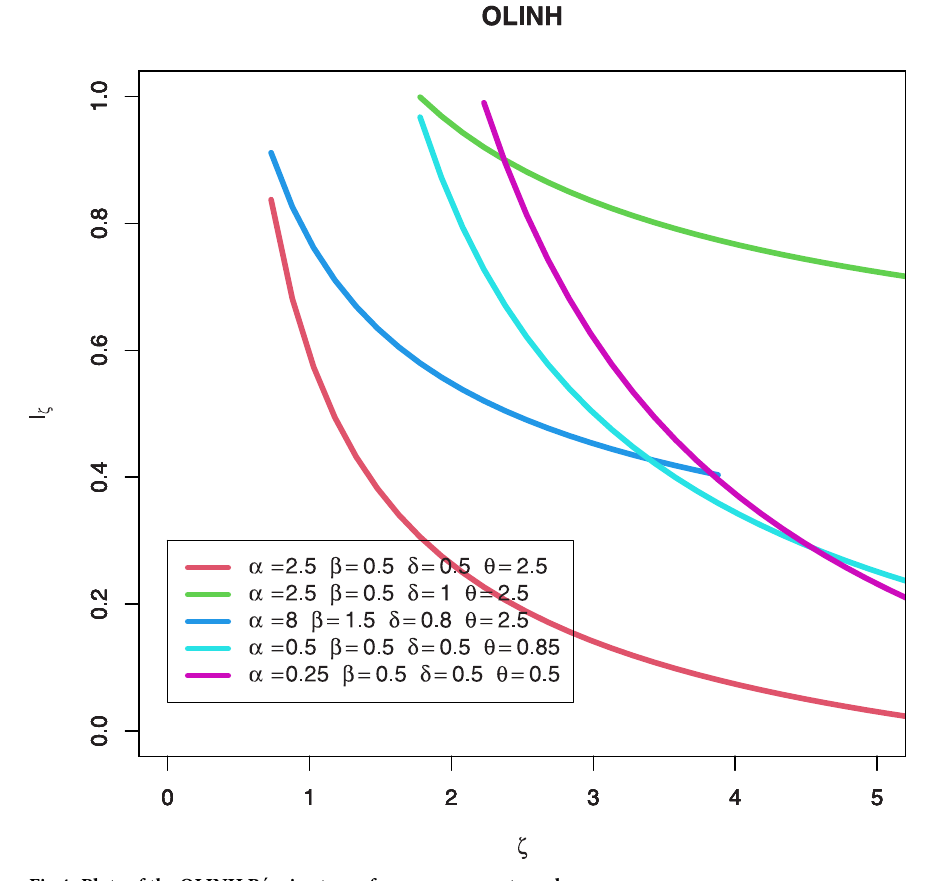
Fig 4. Plots of the OLINH Re´nyi entropy for some parameter